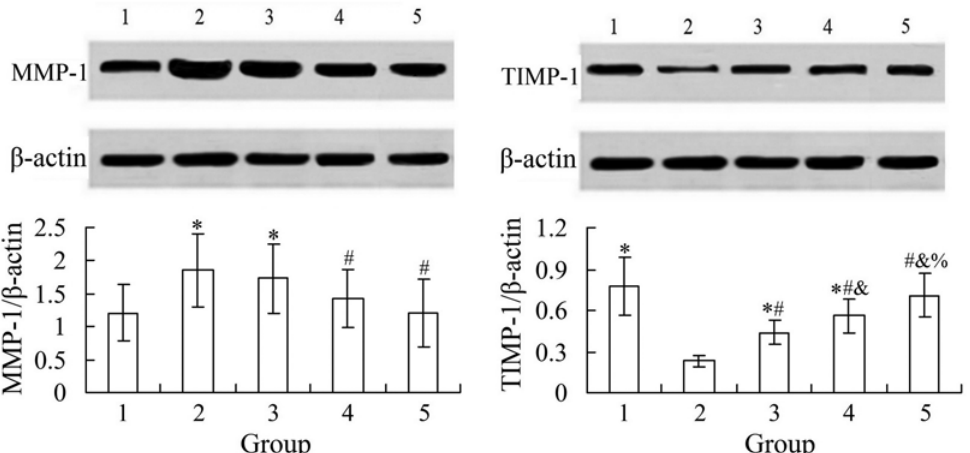
FIGURE 2 - Effects of salidroside on myocardial MMP-1 and TIMP-1 protein expressions in rats. * P < 0.05 compared with sham- operated group; # P < 0.05 compared with model group; & P < 0.05 compared with low-dose salidroside group; % P < 0.05 compared with middle-dose salidroside group. 1: Sham-operated group; 2: Model group; 3: low-dose salidroside group; 4: middle-dose salidroside group; 5: high-dose salidroside group. MMP-1, matrix metalloproteinase-1; TIMP-1, tissue inhibitor of metalloproteinase-1.